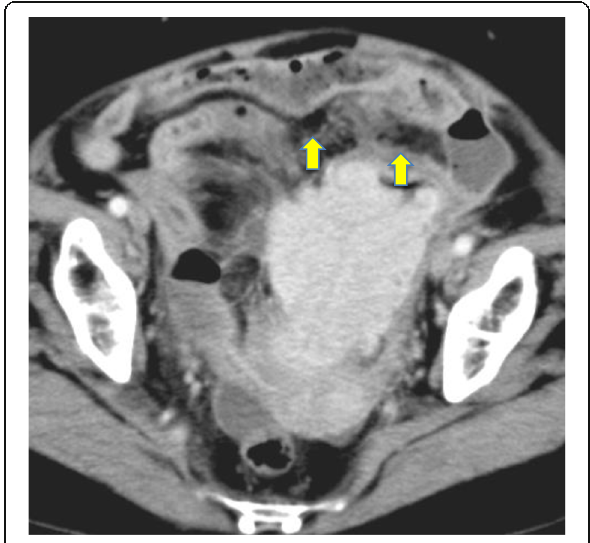
Fig. 1 Plain abdominal computed tomography. Huge tumor is present at the sigmoid colon, and free air (arrows) is seen around the tumor